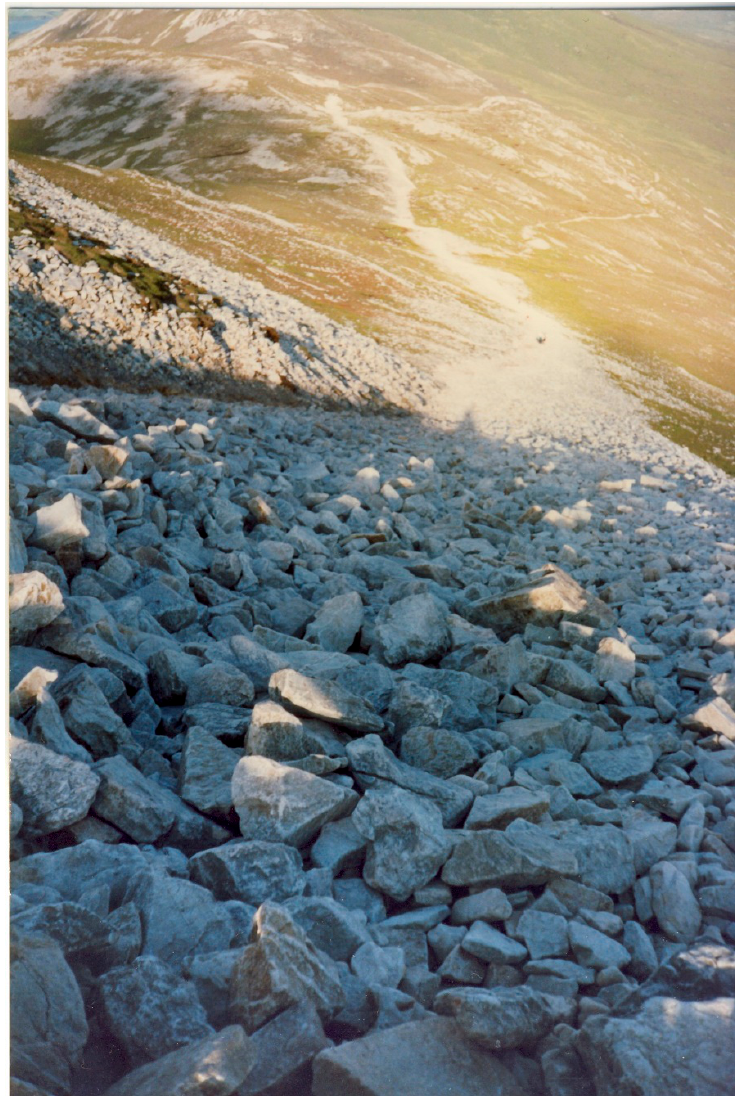
Figure 3. The most difficult part of the pilgrimage route to Croagh Patrick.